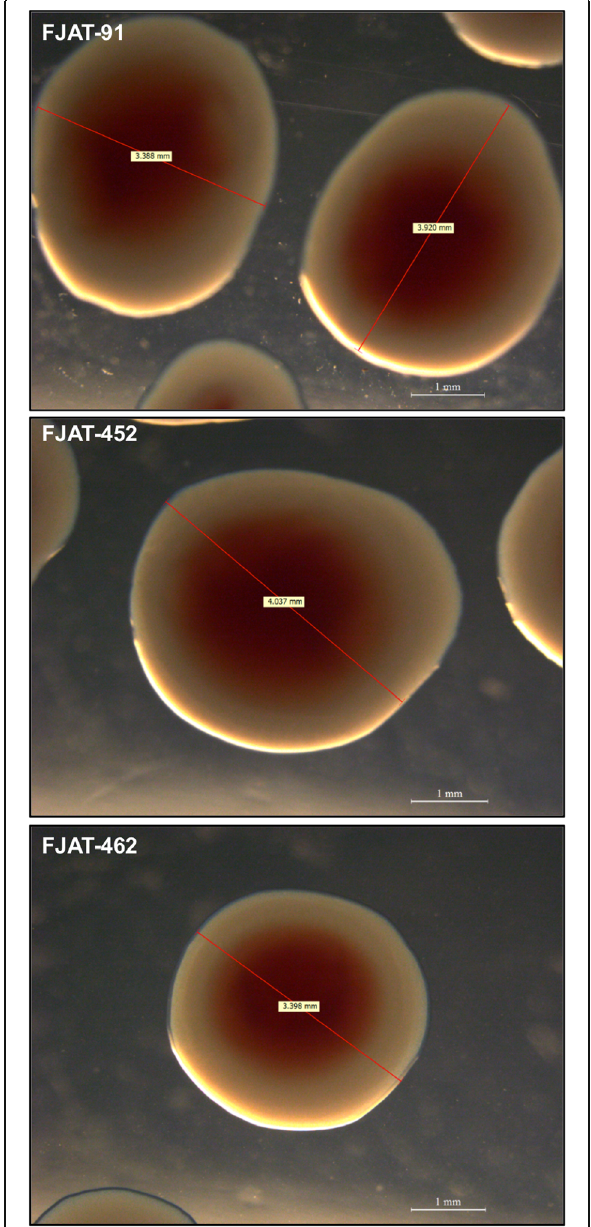
Fig. 1 Images of the Ralstonia solanacearum strains using a stereo microscope to visualize colony morphology on solid medium. The strains were grown on rich medium at 28 °C for 2 days. Scale bars (1 mm) and the size of representative colonies are provided for